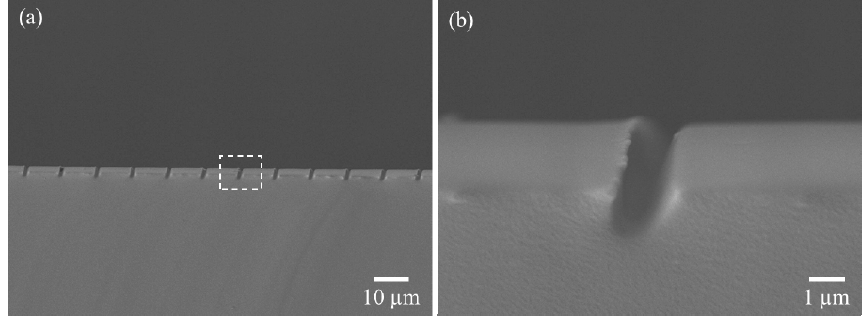
Figure 6. ( a ) Periodic molded groove PDMS patterns at 20°, and ( b ) the shape of the groove.